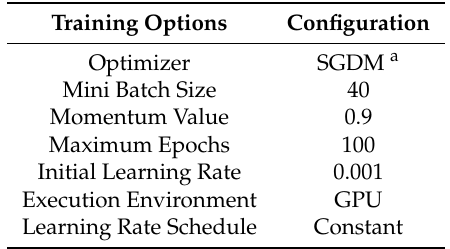
Table 6. Training options for all pre-trained